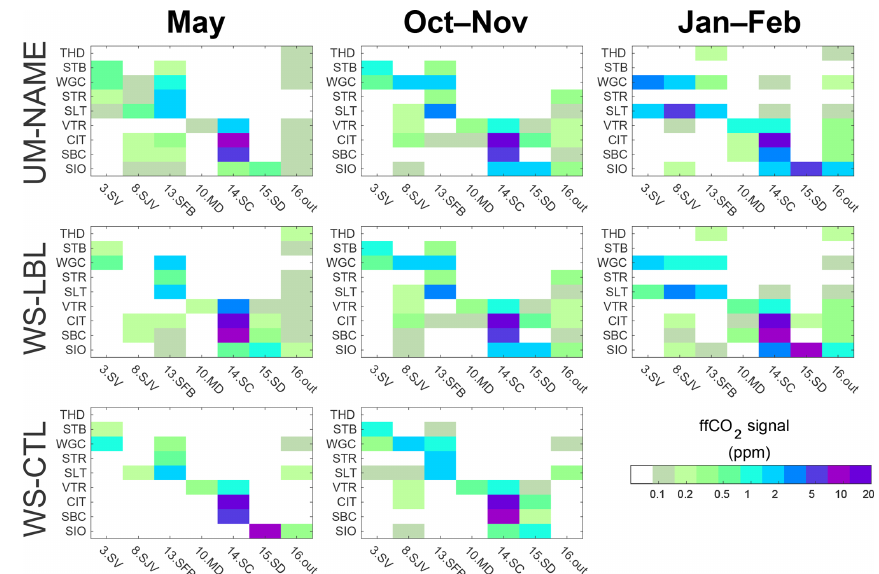
Figure 2. The average ffCO 2 signal (ppm) simulated by each atmospheric transport model as a result of emissions from the six largest emitting air basins and one region outside California (denoted as 16.out) at each observation site over the three measurement campaigns. Signals were simulated based on the EDGAR emission